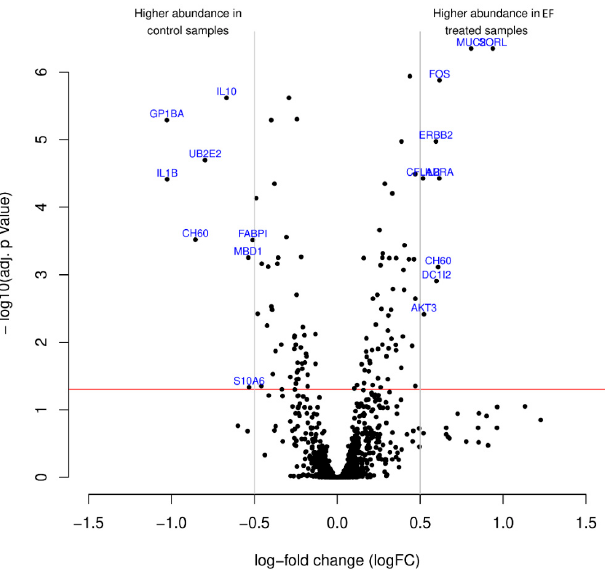
Figure 4. The antibody microarray identified differentially enriched proteins after the treatment of hTCEpi cells with AC EFs. The volcano plot visualizes the p -values (adjusted for multiple testing) and corresponding log-fold changes. The log-fold change of the difference in abundance is shown horizontally, whereas the vertical axis represents the significance level. The logFC cutoffs are depicted as vertical lines. The black dots represent analyzed proteins. The horizontal red line indicates an adjusted p -value of 0.05, above which all proteins are considered to vary significantly. Proteins with a positive log-fold change display higher abundance in EF-treated samples, whereas proteins with a negative value display higher abundance in control samples.